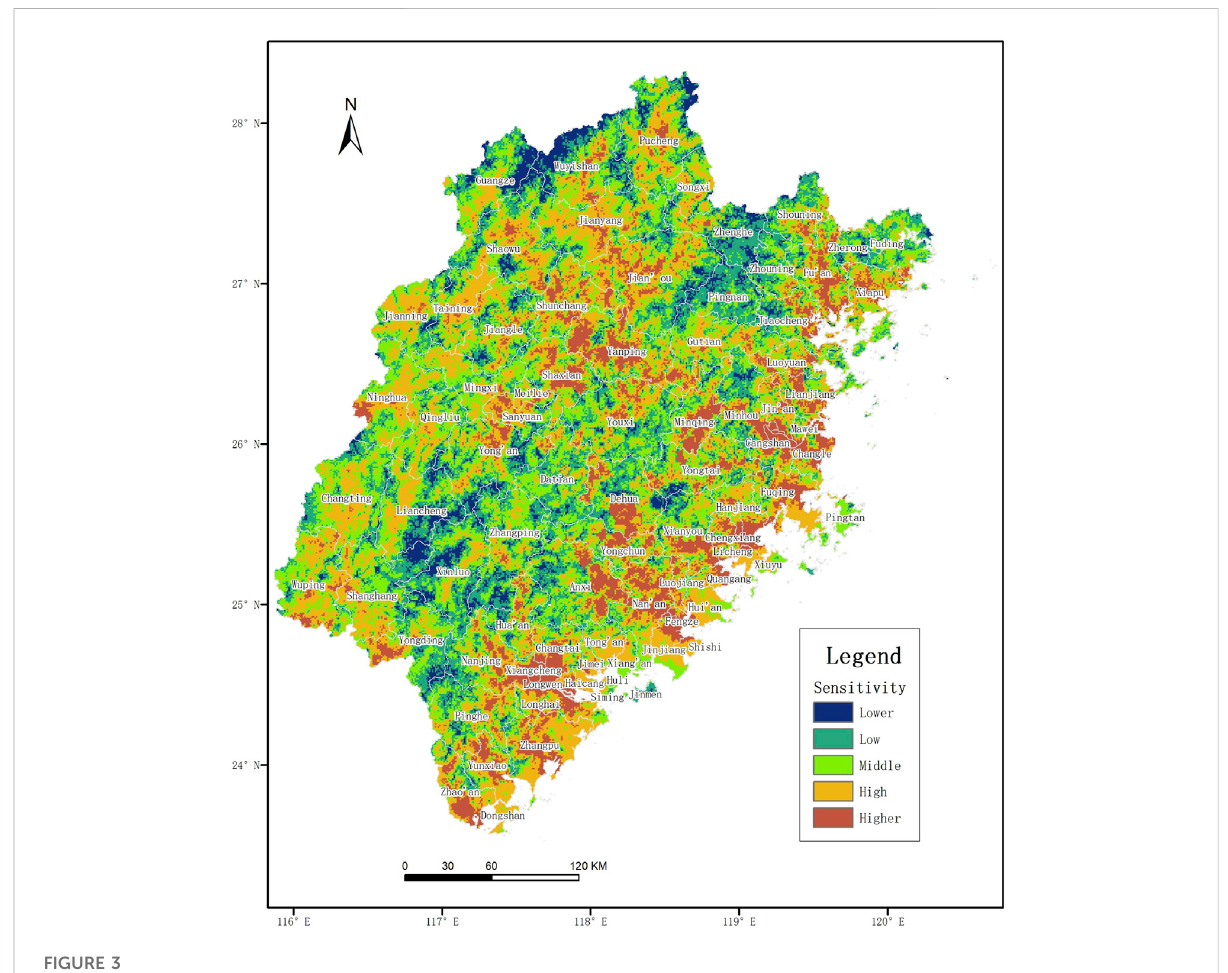
FIGURE 3 Sensitivity of the disaster-formative